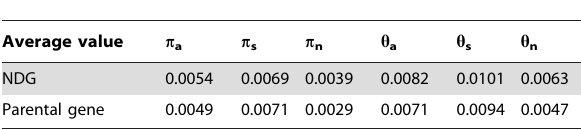
Table 3. The number of NDGs showing selective signatures under population genetic tests. Tajima’s D Fu and Li’s F Fu and Li’s D MK